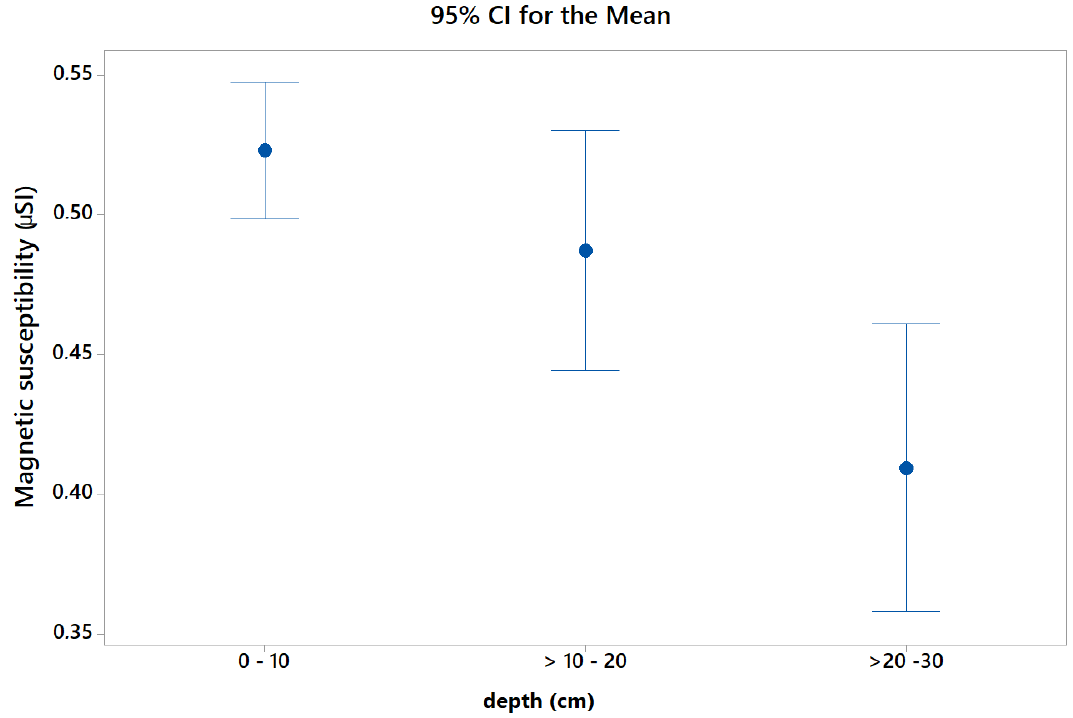
Figure 3. MS values at three sampling depths for a 95% confidence interval (CI).